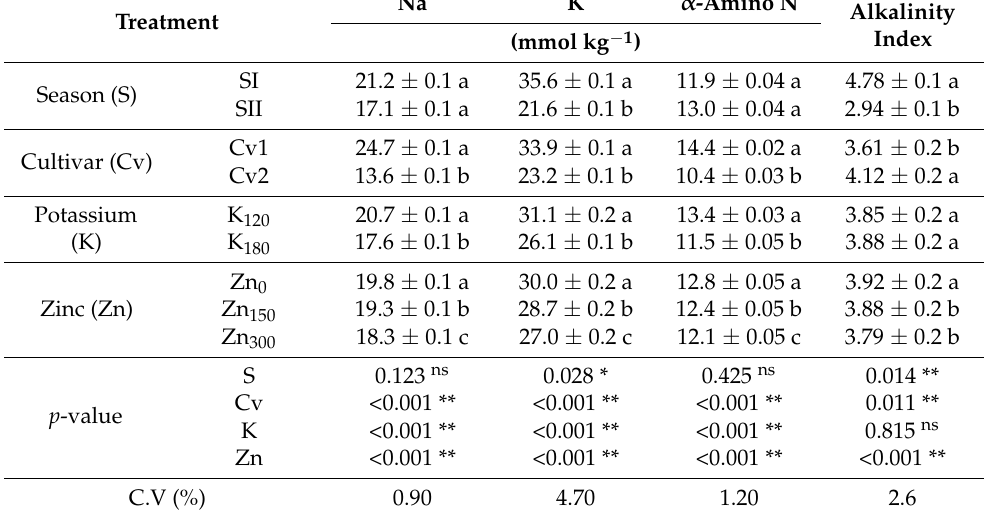
Table 5. Sodium (Na), potassium (K), α -amino N, and alkalinity index of two sugar beet cultivars (e.g., Kawemira (Cv1) and BTS 301 (Cv2)) affected by soil fertilization with two potassium levels (e.g., 120 (K 120 ) and 180 kg ha − 1 (K 180 )) and foliar application with three zinc levels (e.g., 0 (Zn 0 ), 150 (Zn 150 ), and 300 ppm (Zn 300 )) when grown under saline soil (EC e = 8.60 dS m − 1 ) conditions (data pooled over both